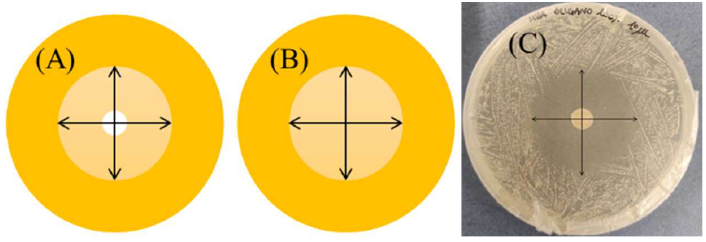
Figure 11. Inhibition zones measured (mm) at the two perpendicular diameters for the agar disk diffusion method ( A ) and the disk volatilization assay ( B ). ( C ) shows a real case measurement.